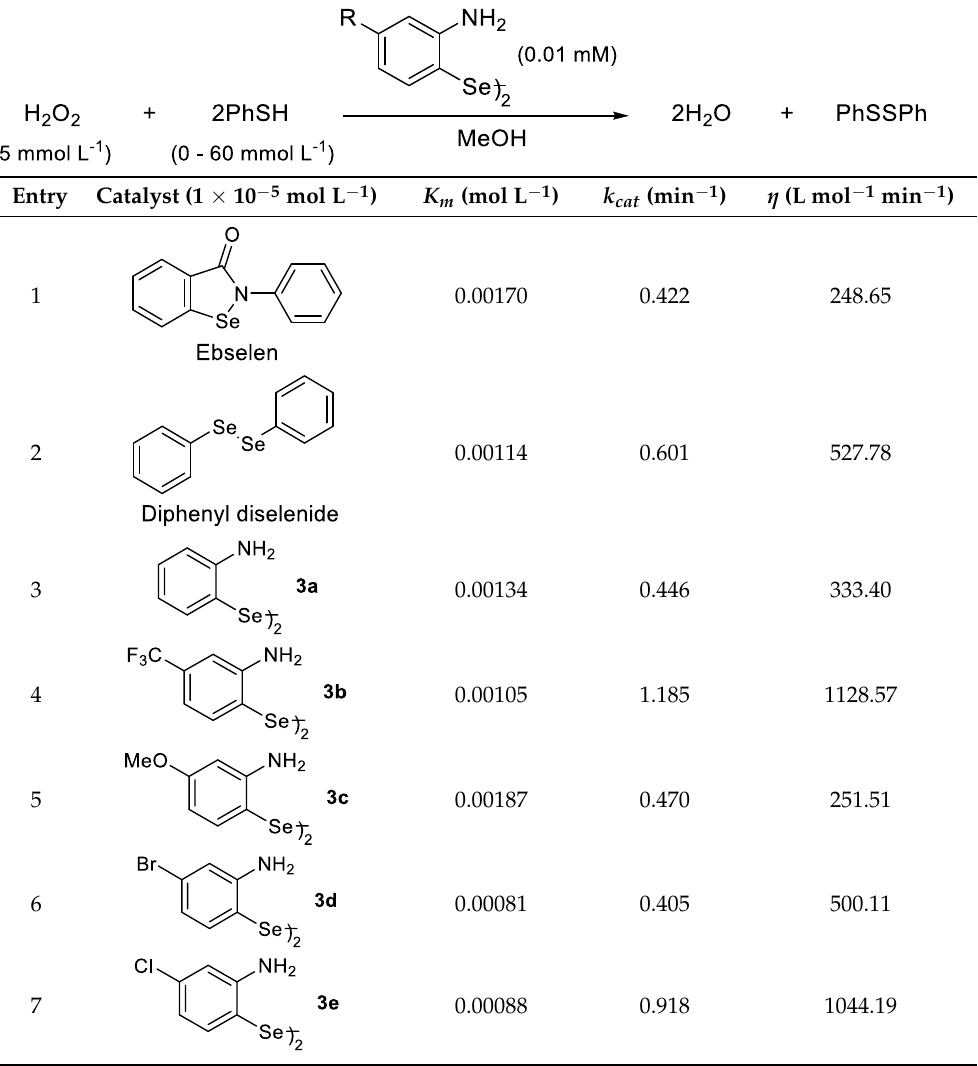
Table 1. GPx-like catalytic evaluation of aniline-derived diselenides 3a-e .